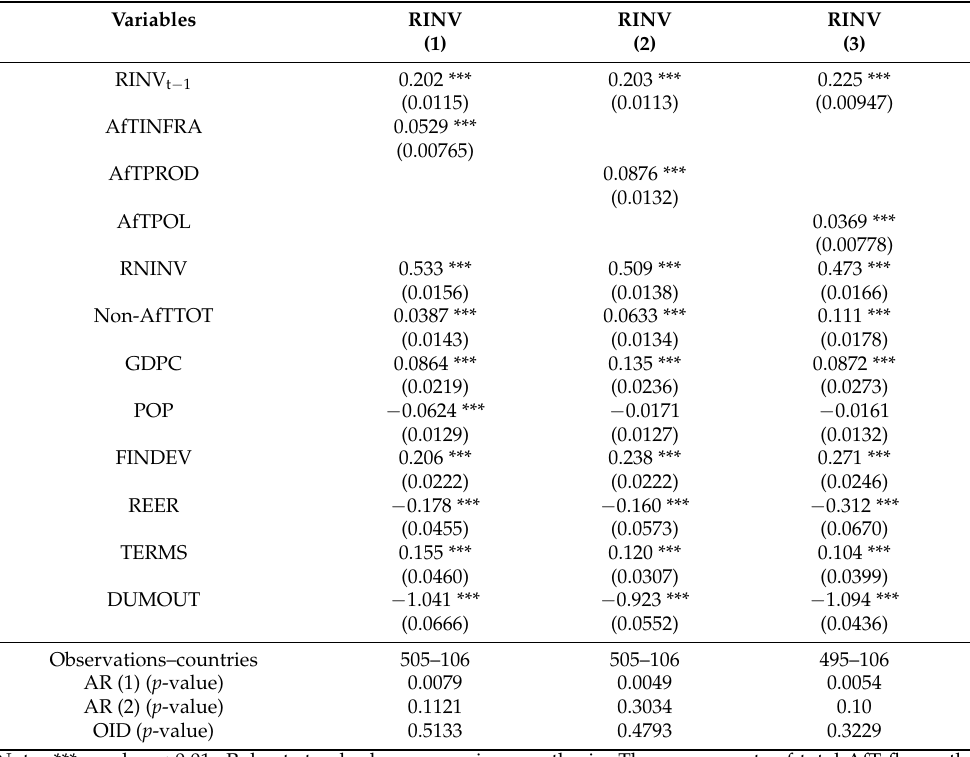
Table 2. Effect of the components of total AfT flows on investment-oriented remittance flows. Estimator: Two-step system